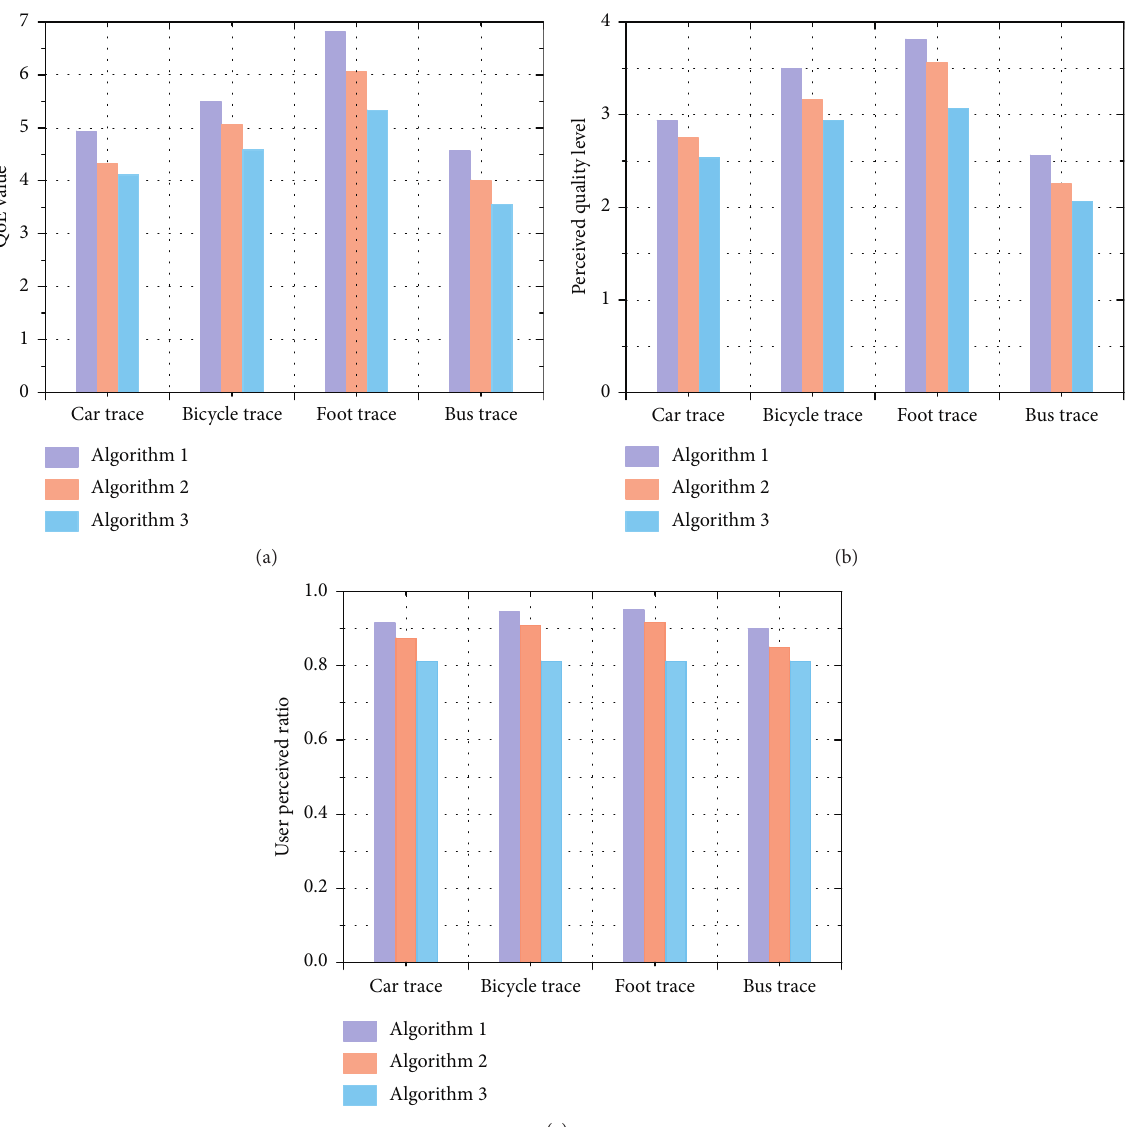
Figure 11: Comparison of 3 streaming schemes over the LTE network. (a) QoE value. (b) Perceived quality level. (c) User perception